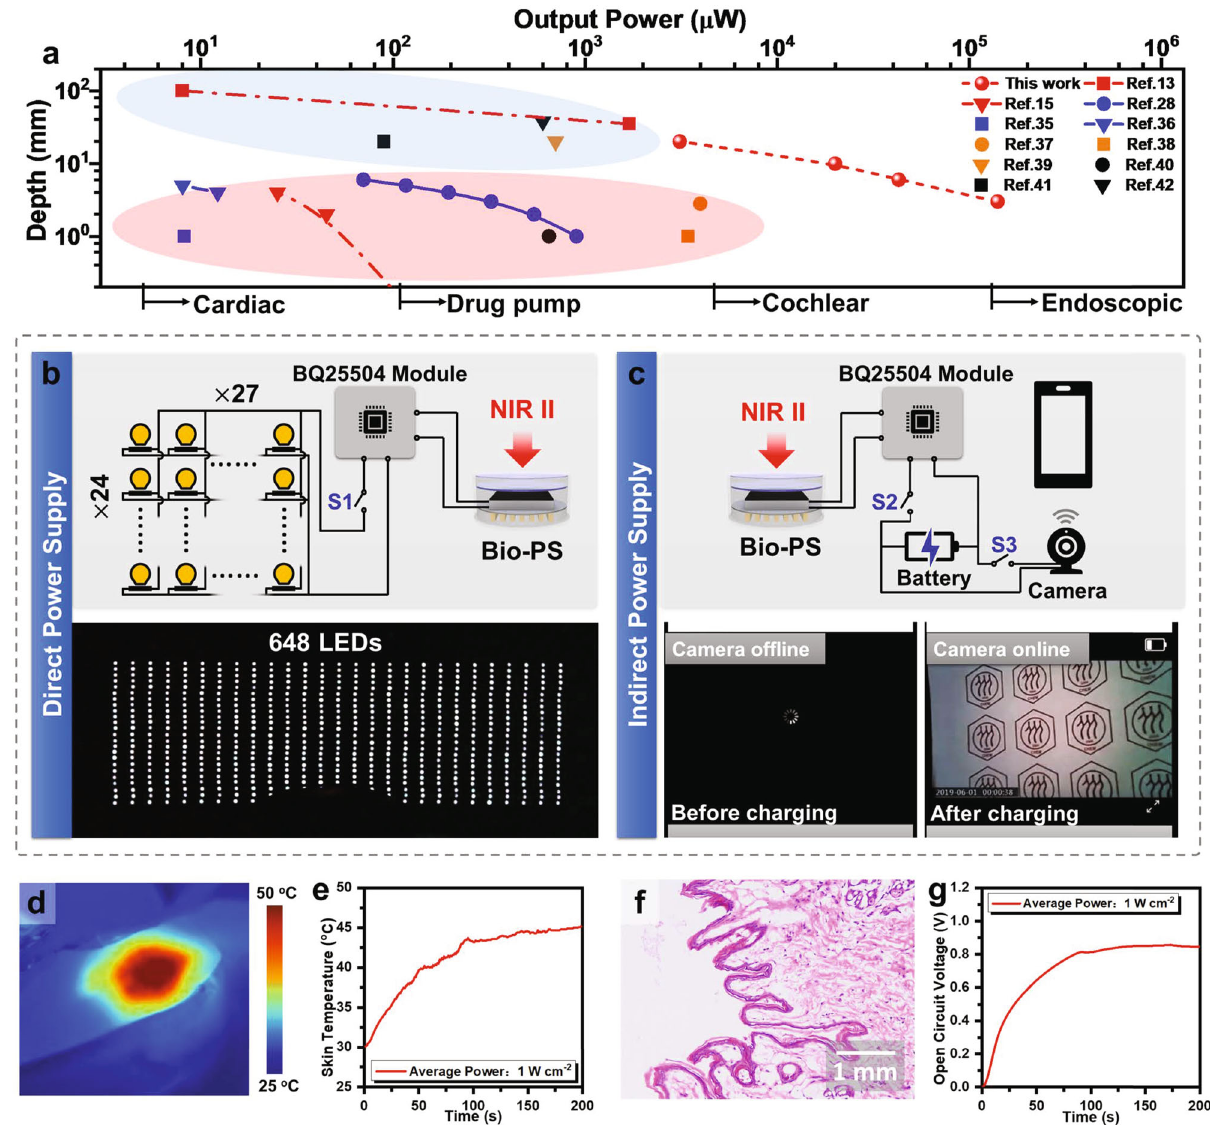
Fig. 5 | In vitro and in vivo assessment of Bio-PS. a The subcutaneous power supply performance of Bio-PS and other CPTs. The data in the red and blue circles correspond to the PV and wireless power transfer, respectively. b Ademonstration of direct power supply for lighting up light-emitting diodes (LEDs) by Bio-PS. Top: ThediagramoftheelectricalconnectionbetweenBio-PSandLEDs(arrayof24*27). Bottom: The photograph of 648 LEDs lightened by a Bio-PS under the coverage of 3.5mm-pigskin under NIR-II light irradiation for 10s under (LPDof1.0Wcm − 2 ). c A